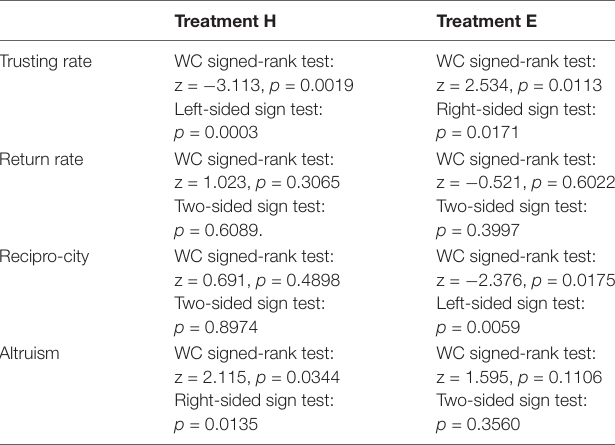
TABLE 7 | Testing the effect of earnings/endowment inequality on TG decisions. Treatment H Treatment E Trusting